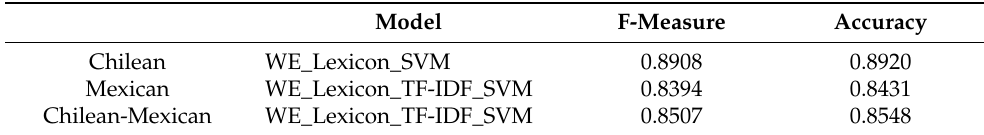
Table 11. Models with the best performance in the corpus.